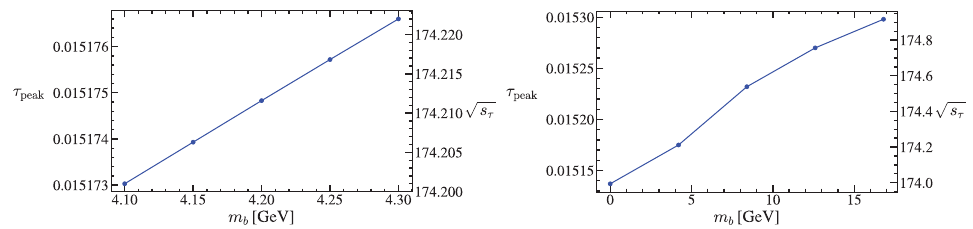
Figure 7: Peak position for the thrust distributions as a function of the bottom mass in GeV units. We also show the corresponding value for the hemisphere jet invariant mass